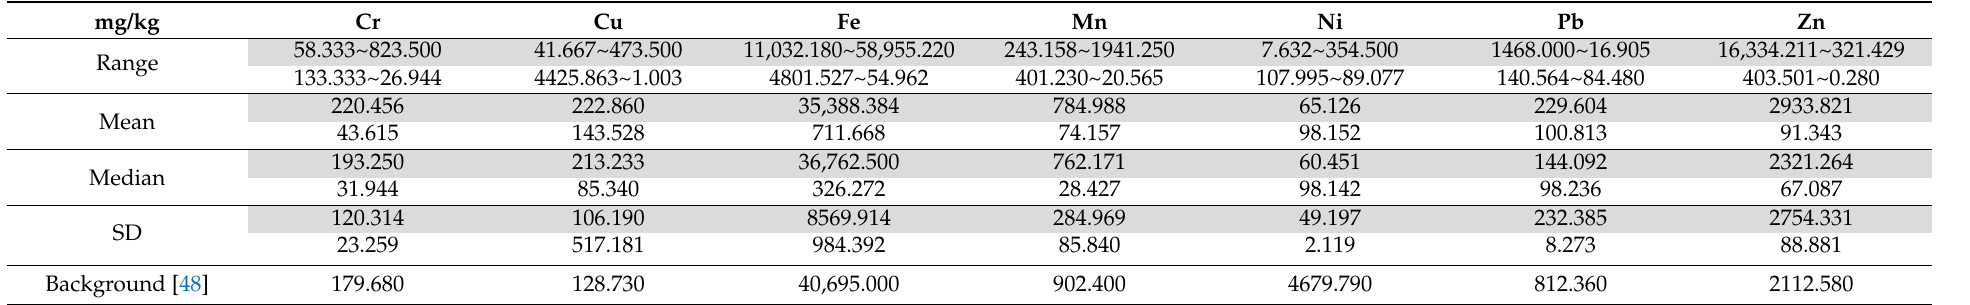
Table 2. Heavy metal element content in